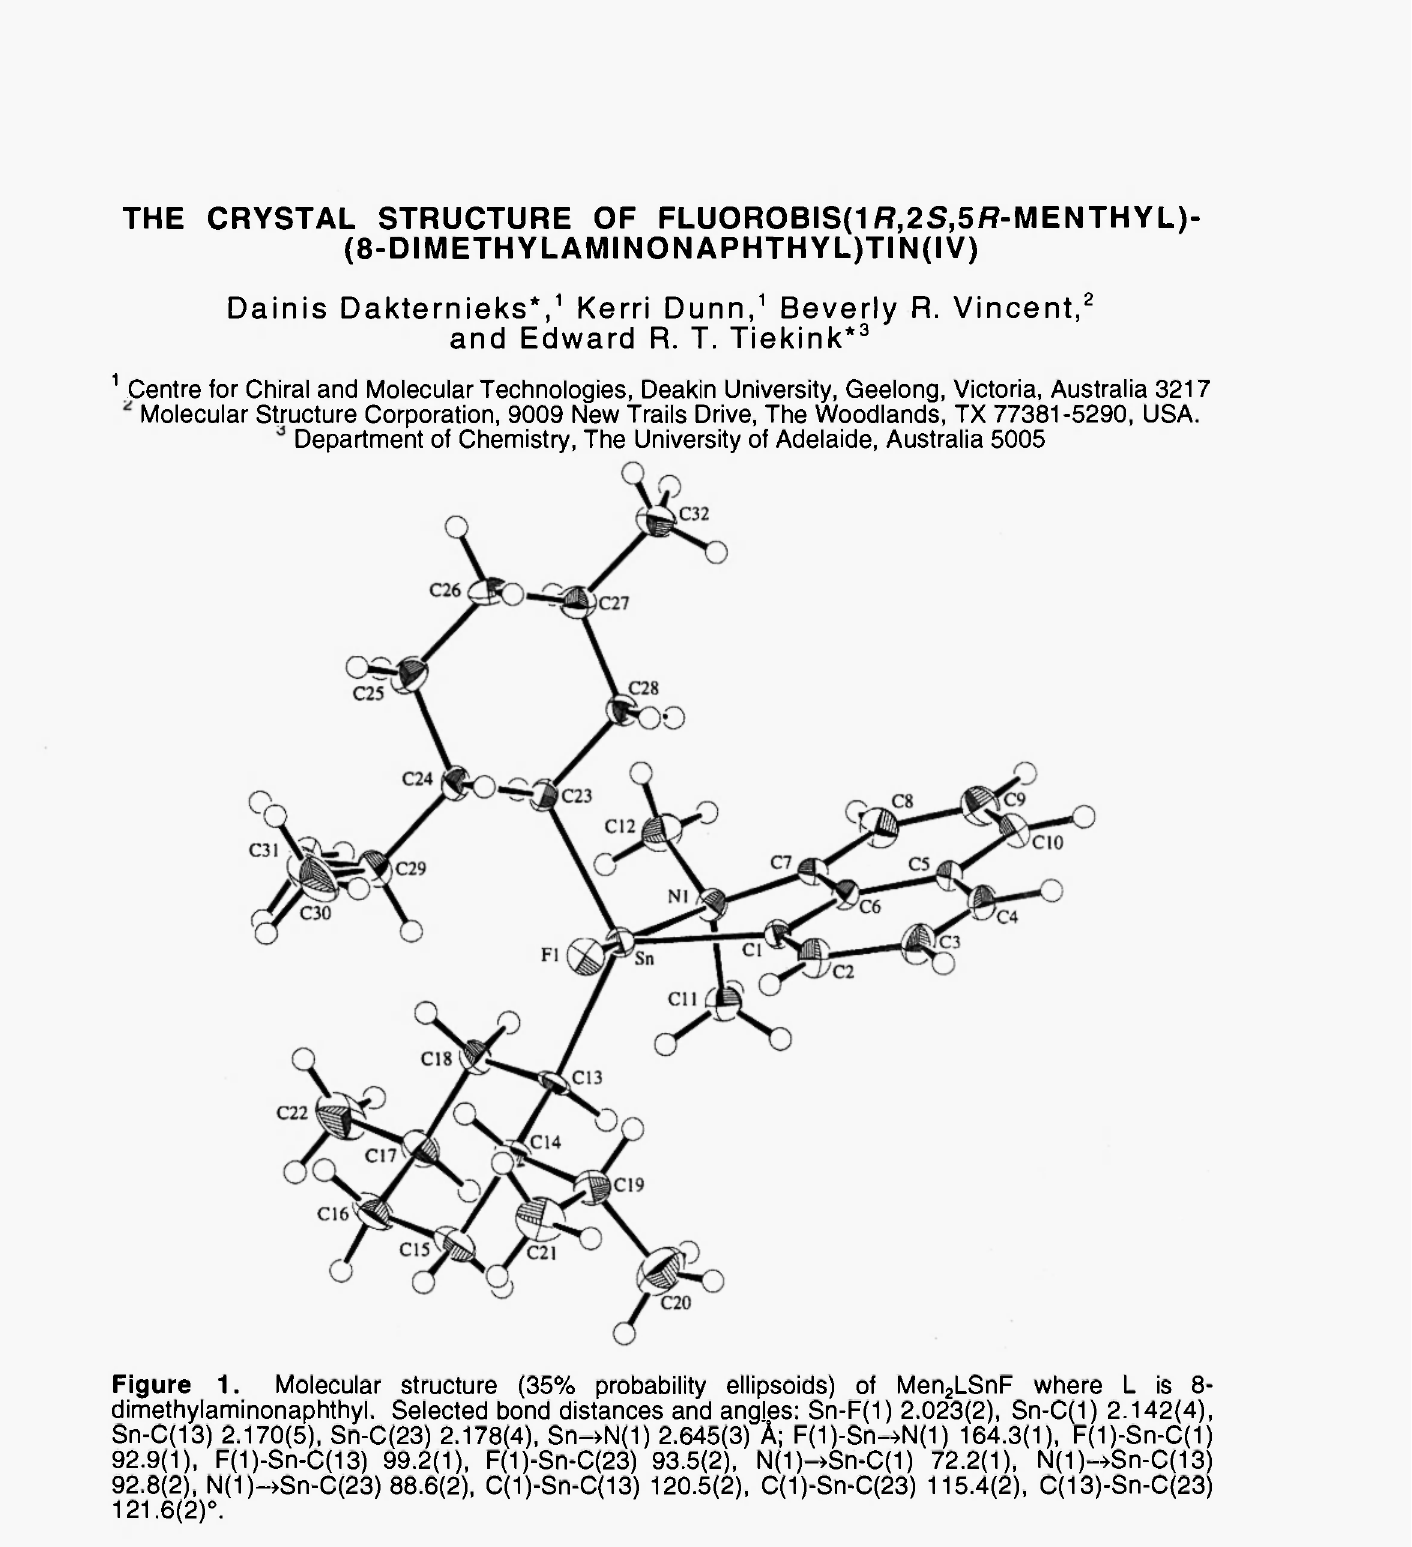
The tin atom in Men 2 LSnF tends towards five coordination owing to the close approach of the amino-nitrogen donor atom. In this description, the tin atom exists in a distorted trigonal bipyramidal geometry with the F and Ν atoms defining the axial positions. The tin atom lies 0.1997(3) Ä out of the C 3 plane in the direction of the F